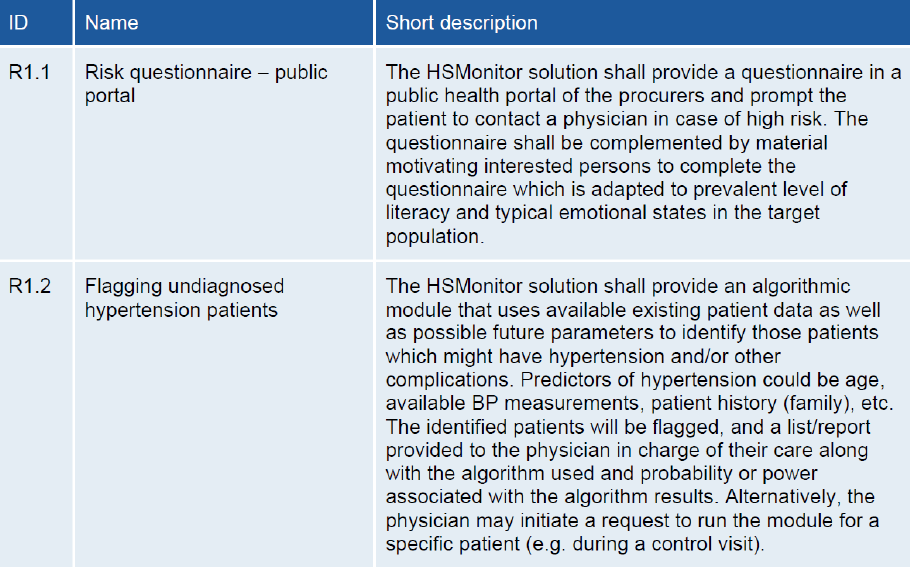
Figure 3. An example of HSMonitor functional requirements.